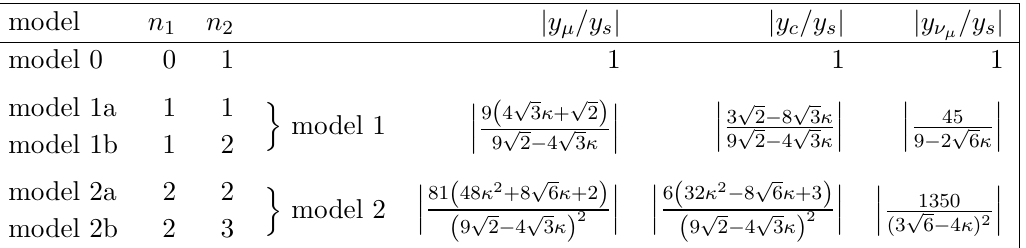
Table 9 . Models with di(cid:11)erent choices of n and n 0 in O 22 and their predictions for Yukawa ratios. charges to the representations. We label the charges of 16 and h , respectively. The net zero charge of O